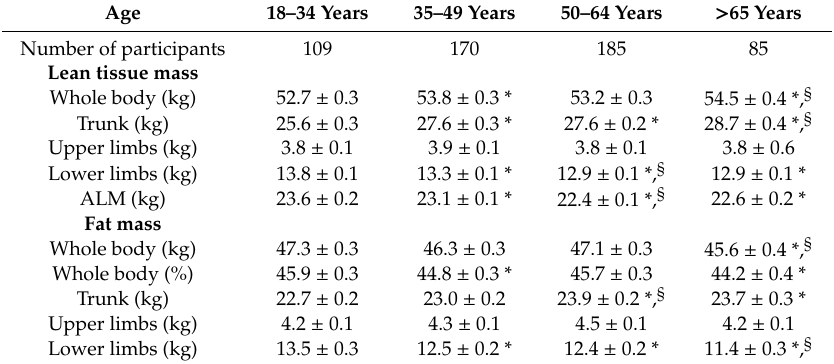
Table 3. Segmental body composition adjusted for weight and height according to the age bracket in